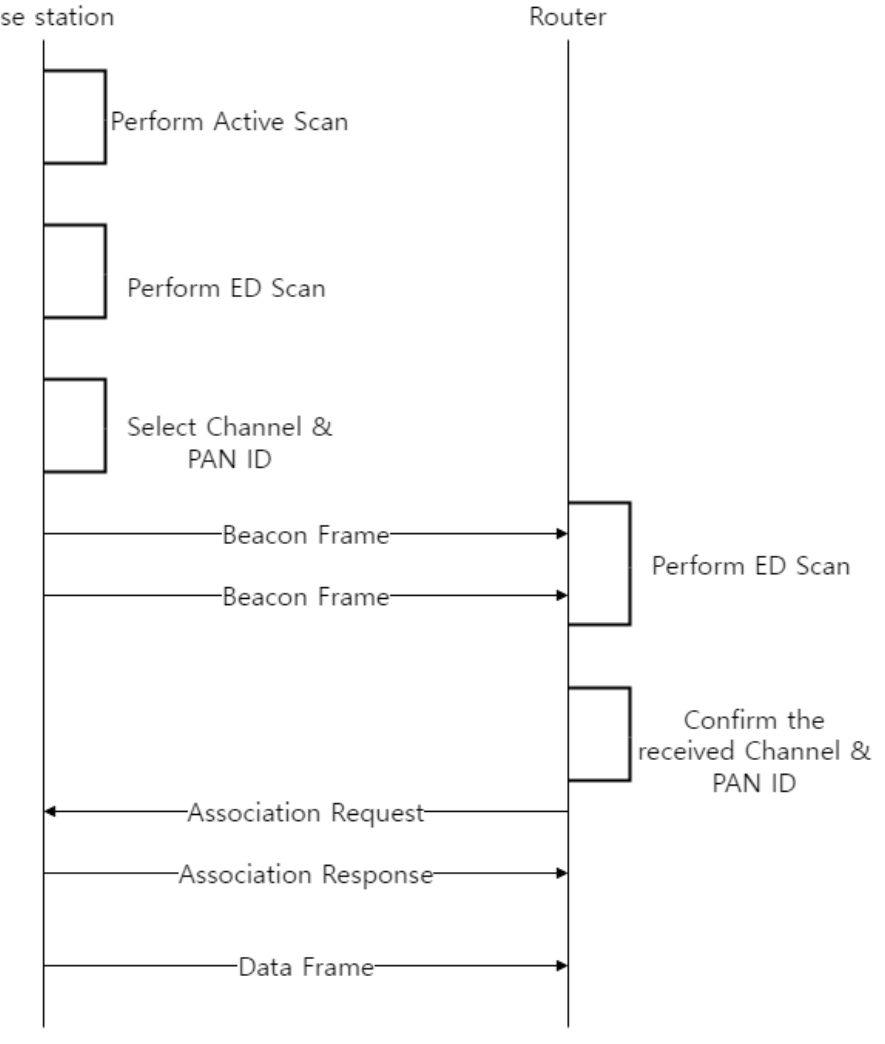
Figure 5. The timing diagram for constructing the PAN in the TSMR .